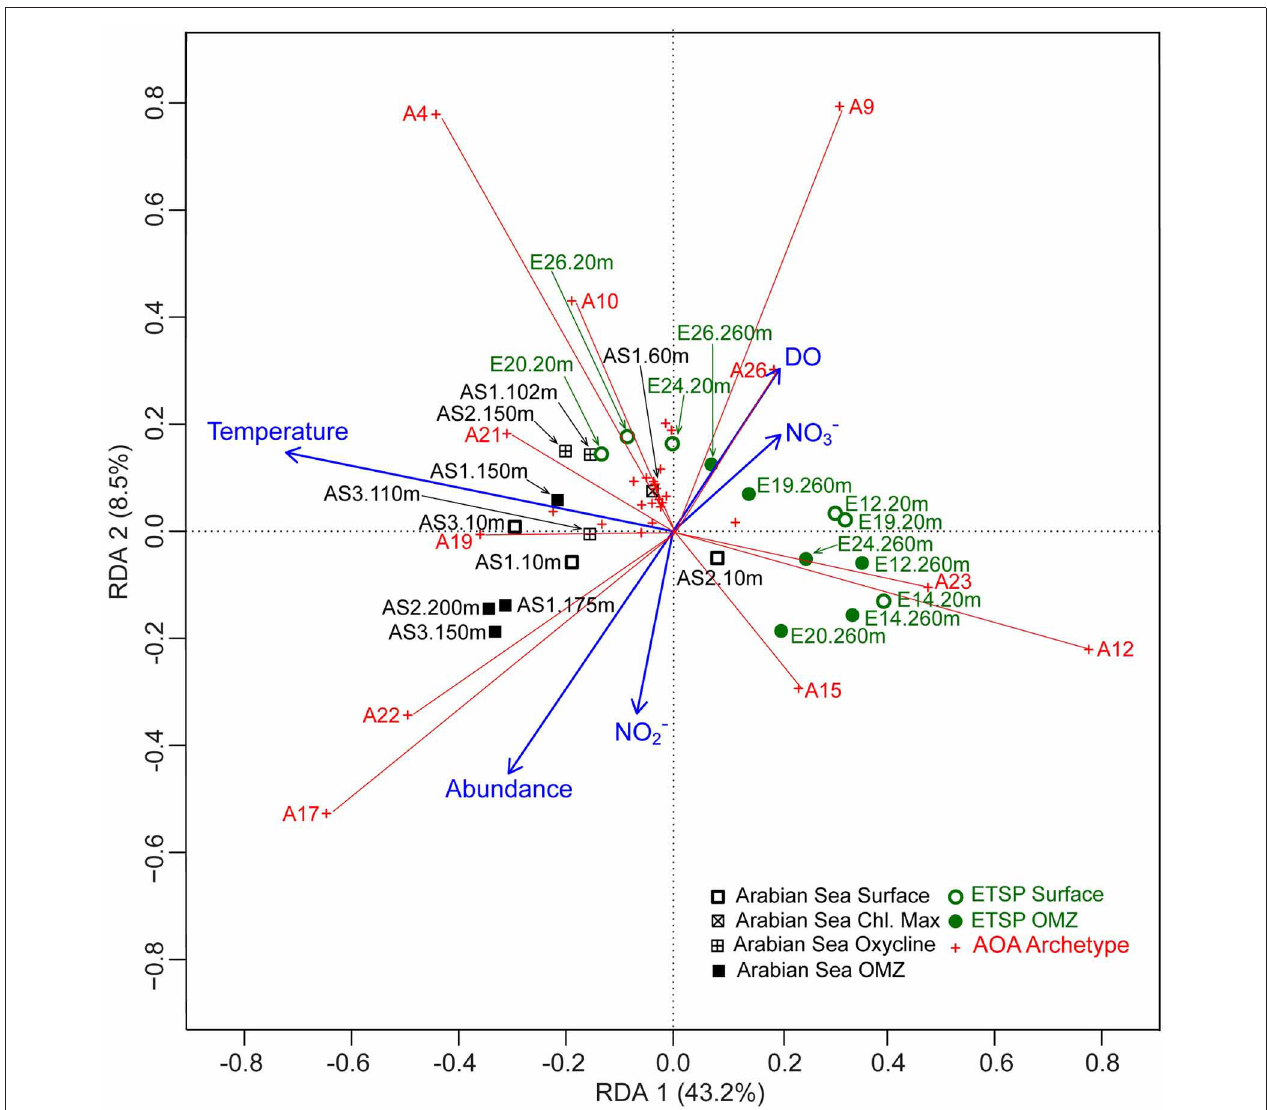
FIGURE 5 | Distance triplot of redundancy analysis (RDA) on AOA community composition from the Arabian Sea and the ETSP, using temperature, dissolved oxygen (DO), archaeal amoA abundance, nitrite concentration (NO − 2 ), and nitrate concentration (NO − 3 ) as explanatory variables. Symbols used here for AOA archetypes and sample stations are the same as described in Figure 3 . The blue arrows